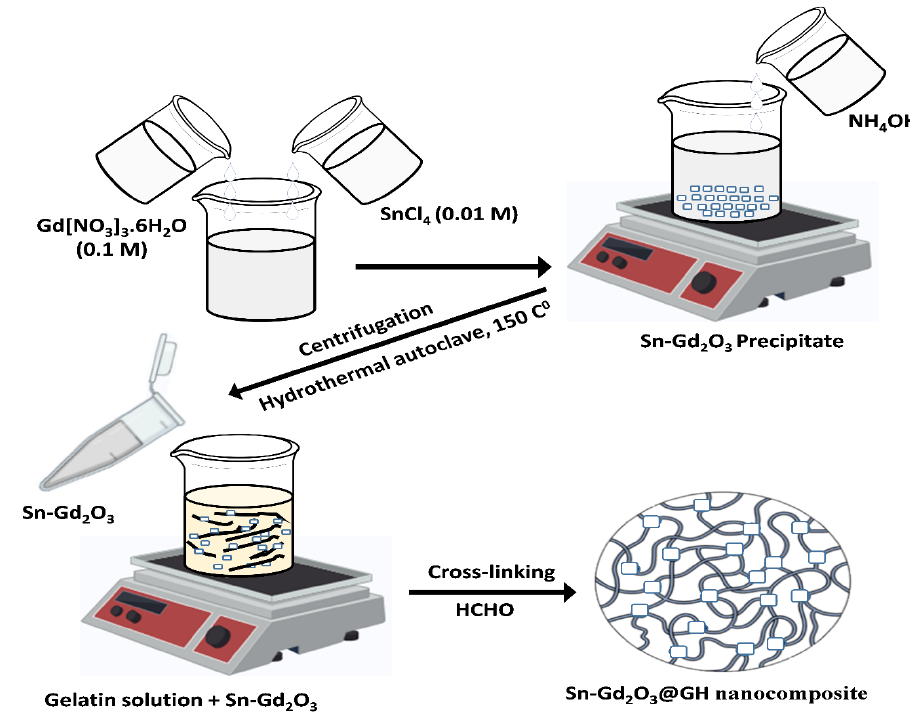
Figure 1 . Preparation of Sn-Gd 2 O 3 @GH nanocomposite. Figure 1. Preparation of Sn-Gd 2 O 3 @GH